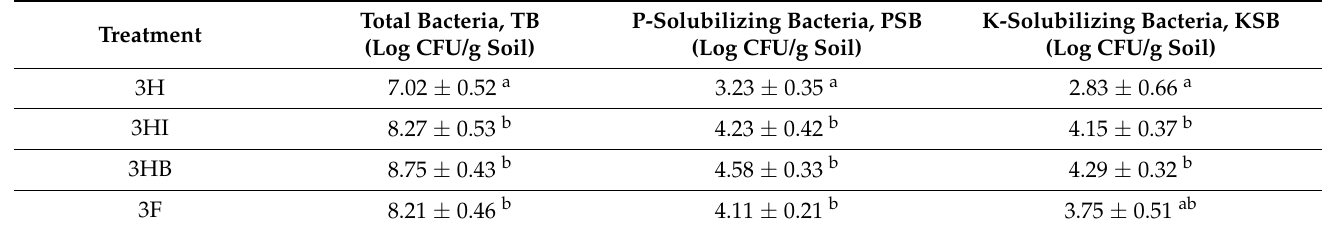
Table 1. Effect of free-cell and encapsulated E. hormaechei 40a on the populations of culturable bacteria in soil. Data (mean ± standard deviation, n = 4) followed by different letters between treatments indicate significant differences (one-way ANOVA + Tukey multiple comparisons test at p < 0.05).